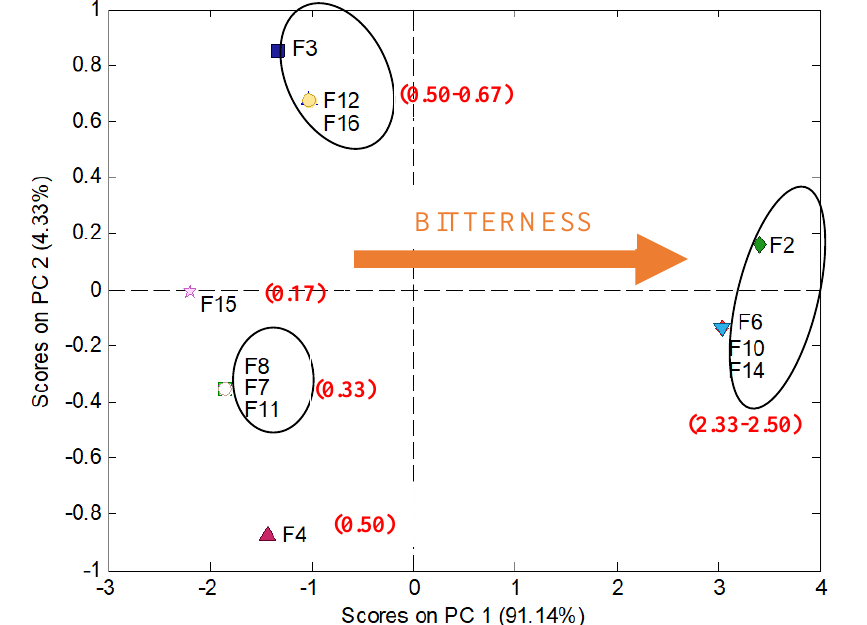
Figure 6. PC1, PCA of human panel responses showing similarity of sensed bitterness for the studied minitablets. Values in brackets show mean values of bitterness score calculated from Table 5.